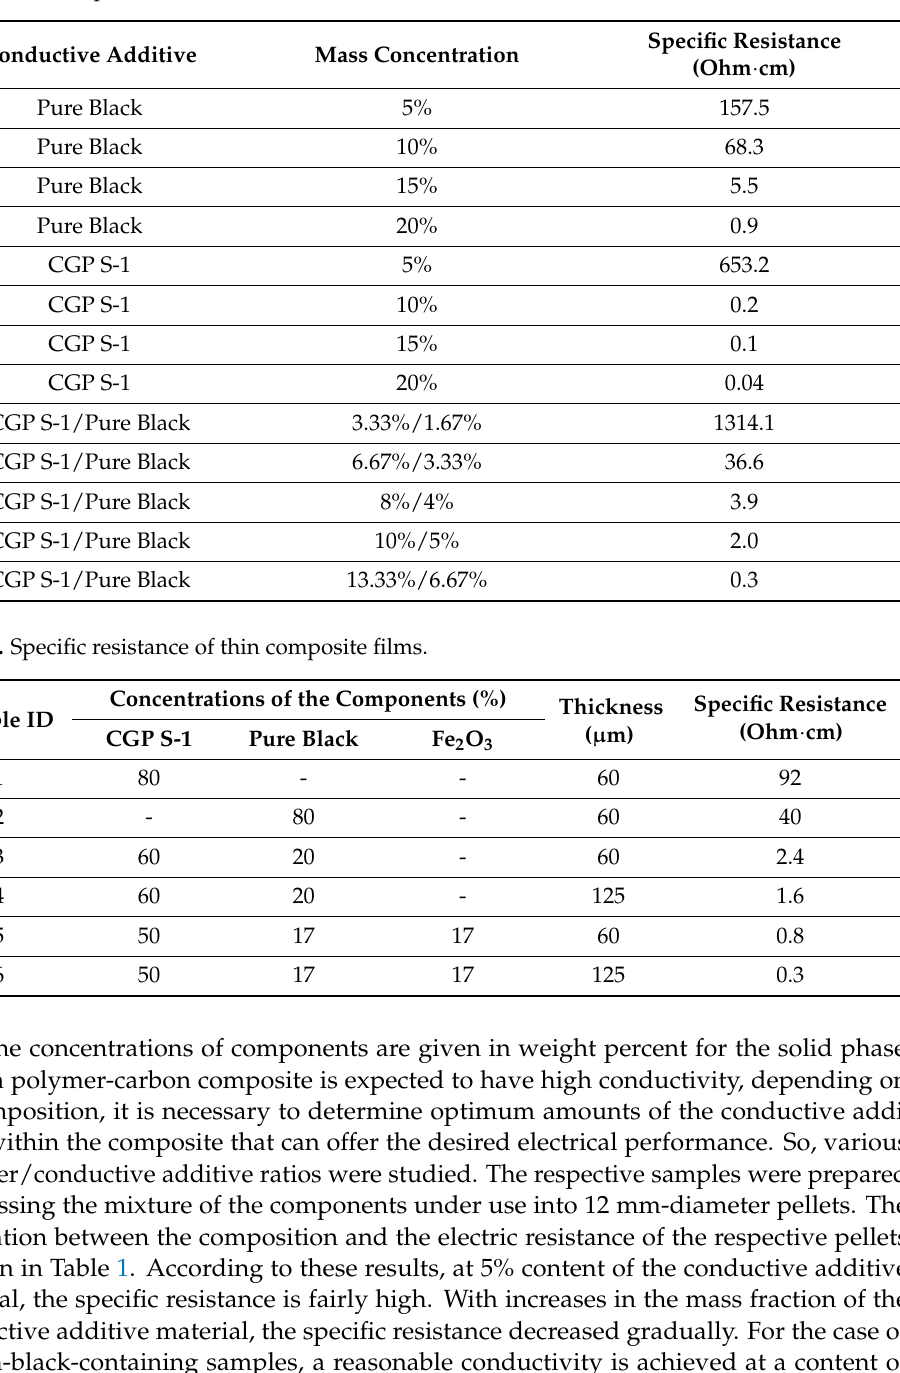
Table 1. Effect of carbon material and its mass concentration (weight %) on the specific resistance of dry pelleted composite material.